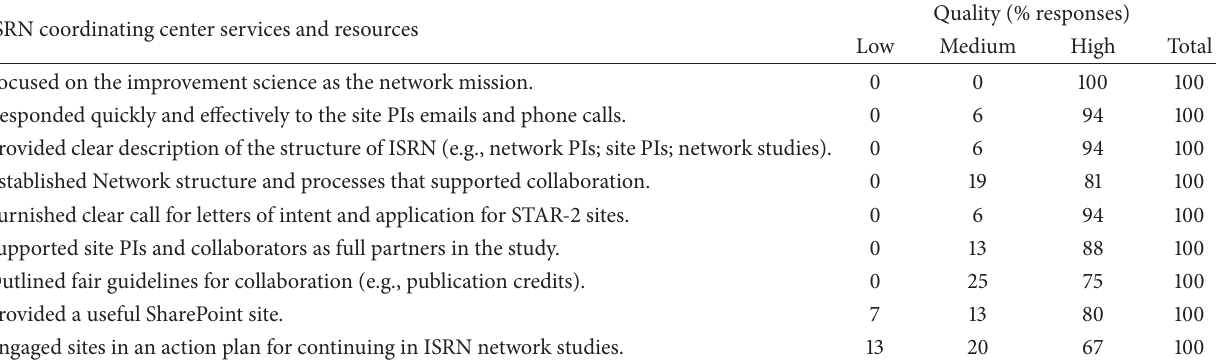
Table 4: Summary on the quality of services offered by the ISRN coordinating center. ISRN coordinating center services and resources